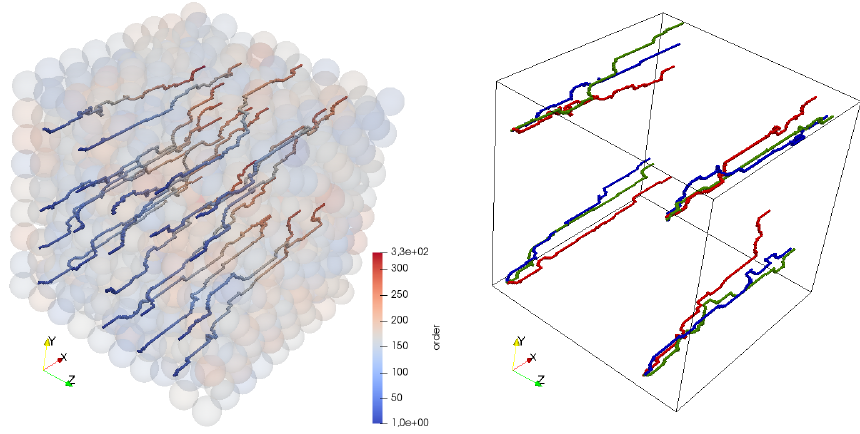
Figure 13. Paths calculated by the Path Searching Algorithm (resolution 200 × 200 × 200).